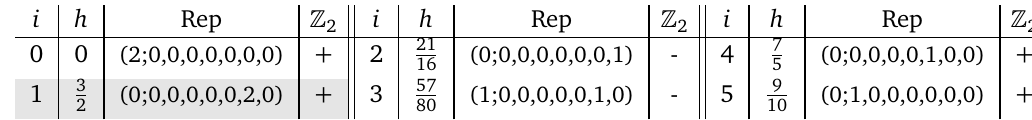
) Table 20: ( E : primaries labeled by i are characterized by weights h and E 7 2 Their characters are denoted by χ (cid:90) 2